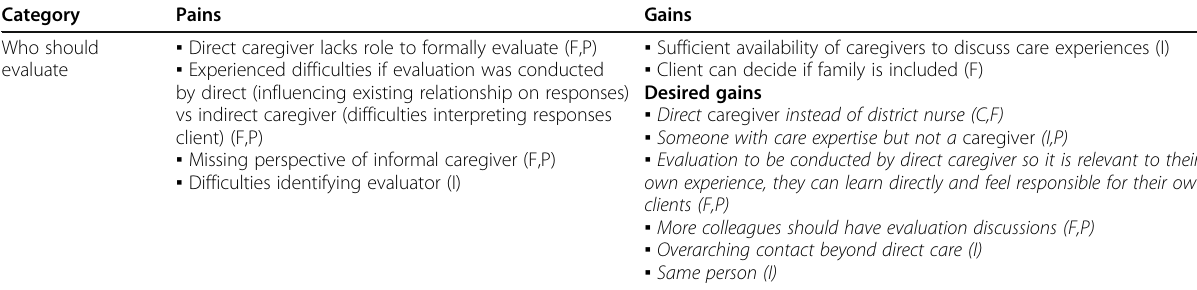
Table 4 Identified pains and (desired) gains for ‘ who should evaluate ’ Category Pains Gains Who should evaluate